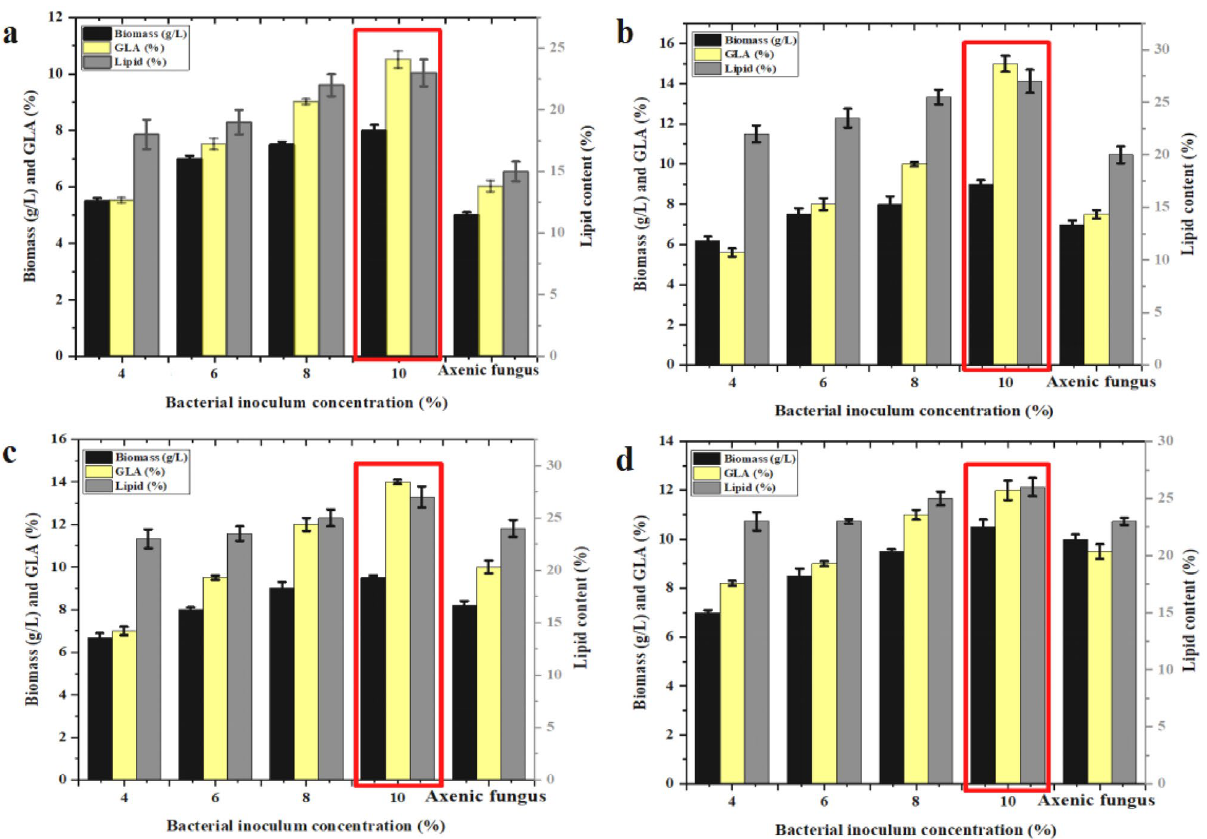
Figure 3. Effect of different bacterial inoculum concentrations cocultured in K&R fermentation media with target fungal strain 6697.A on biomass, lipid, and GLA yields at ( a ) 24 h, ( b ) 48 h, ( c ) 72 h, and ( d ) 96 h. Error bars represent the SD across three biological replicates.